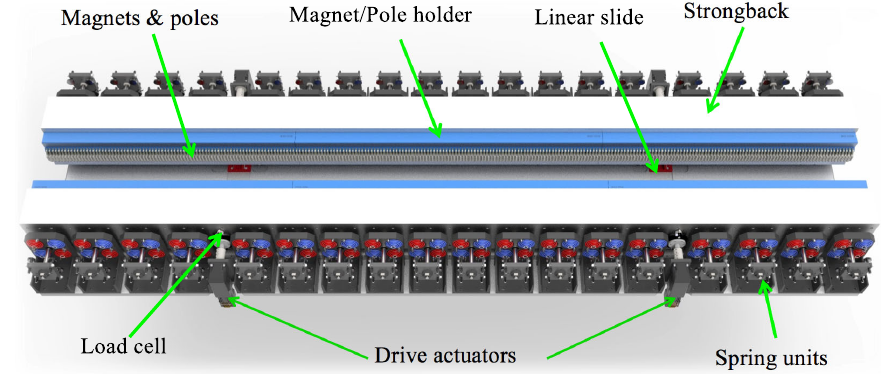
FIG. 2. Design rendering of the HGVPU gap drive mechanism. The linear slides are at the same positions along the undulator as the drive actuators. The blue and red coloring on the springs in the spring units indicates weaker and stronger, respectively. Combining their response curves and adjusting the engagement points using the spring calibration buttons (see Fig. 3) allows a better match to the gap dependence of the magnetic